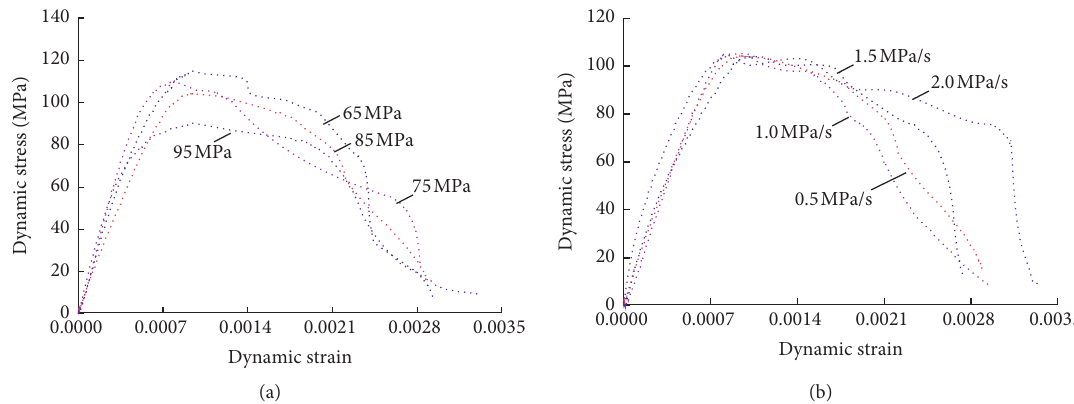
Figure 3: Envelope of typical dynamic stress-strain curve. (a) The axial unloading rate is 0.5MPa/s. (b) The pre-added axial pressure is 85MPa.